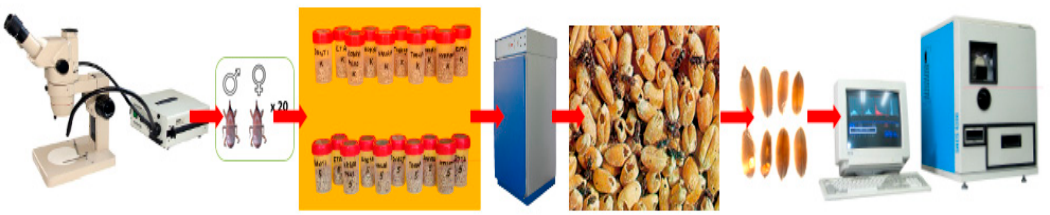
Figure 2. Scheme for obtaining empirical data [17].